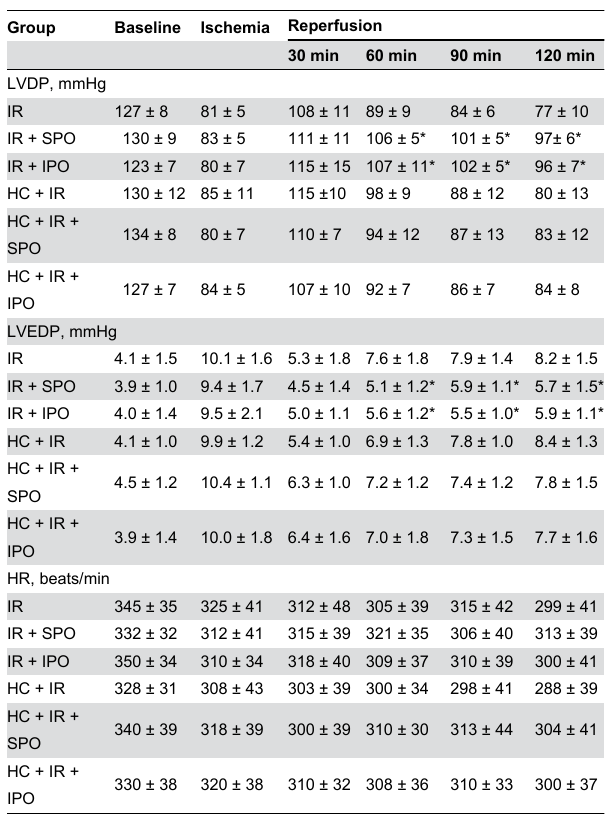
Effects of sevoflurane and ischemic postconditioning on left ventricular hemodynamic parameters in rat hearts exposed to ischemia-reperfusion. IR: ischemia reperfusion; SPO: sevoflurane posconditioning; IPO: ischemic posconditioning; HC: hypercholesterolemia. Data are mean ± SD, n = 8